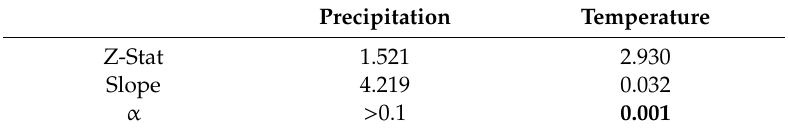
Table 2. Temporal trends in annual precipitation and temperature in the LEC watershed. Precipitation